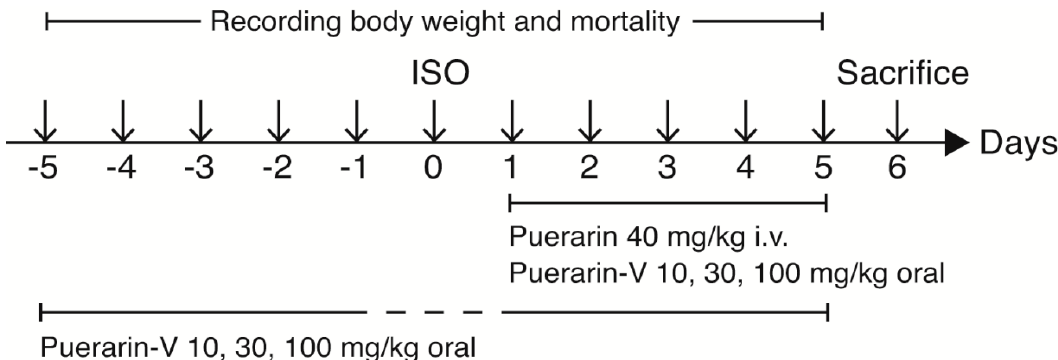
Figure 9. Schematic representation of animal experimental design.